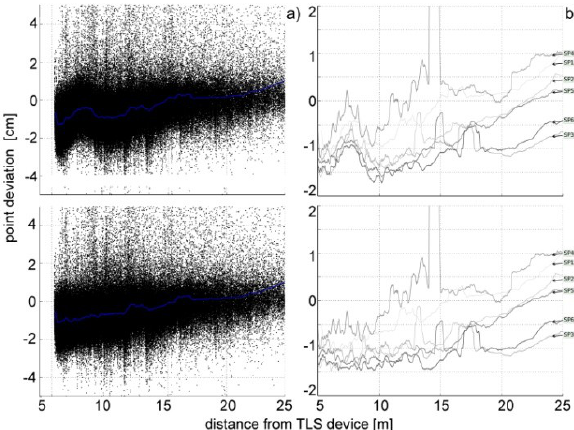
Figure 5: Systematic error of TLS compared to UAV data (14.02.2014). a) Point deviations between surface mesh from UAV photogrammetry and uncorrected (upper image) and corrected (lower image) TLS point cloud of SP 1, b) averaged point deviations of all SPs.